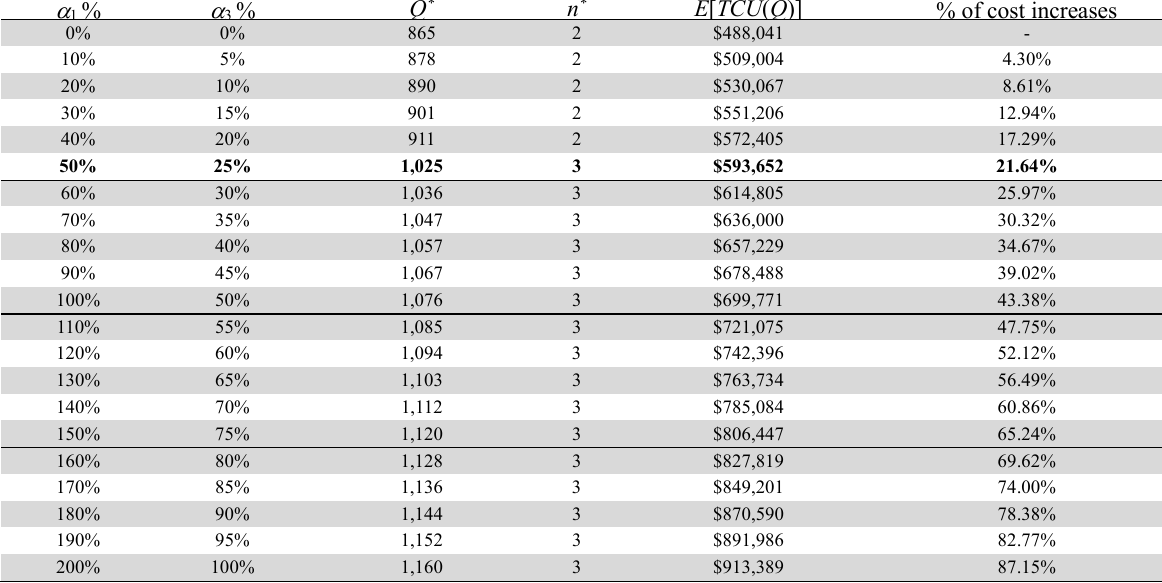
Joint effects of variations in adjusted factors α 1 and α 3 on the optimal replenishment lot size and shipments, the expected total system cost, and system cost increase %